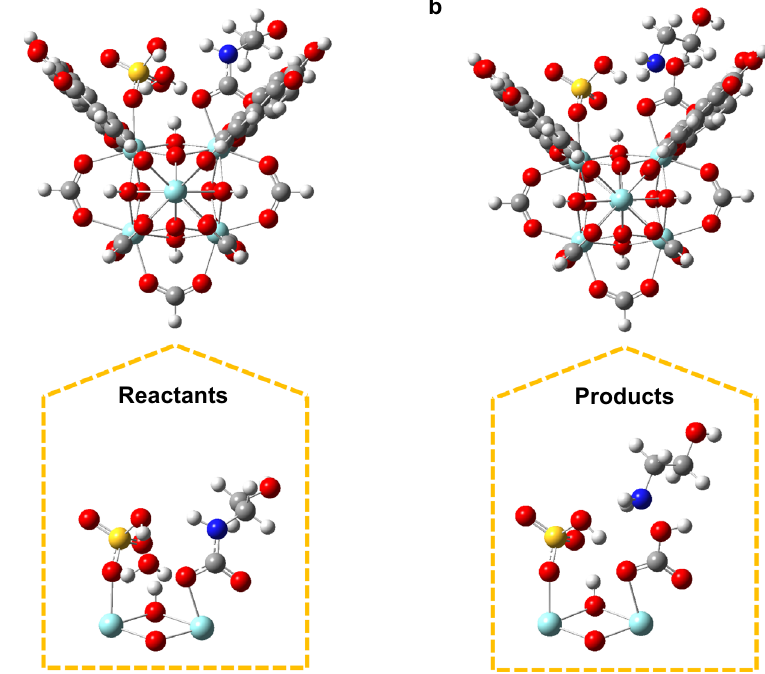
Fig. 7 Reactants and products for the decomposition of carbamate on a Fe 3 O 4 @UiO-66 – SO 4 defect active site. a Reactants. b Products. The full fragment is shown in the upper panel, and a rotated view of the defect active site alone is shown in the lower panel. Zirconium, sulfur, oxygen, nitrogen, carbon, and hydrogen are colored cyan, yellow, red, blue, gray, and white,